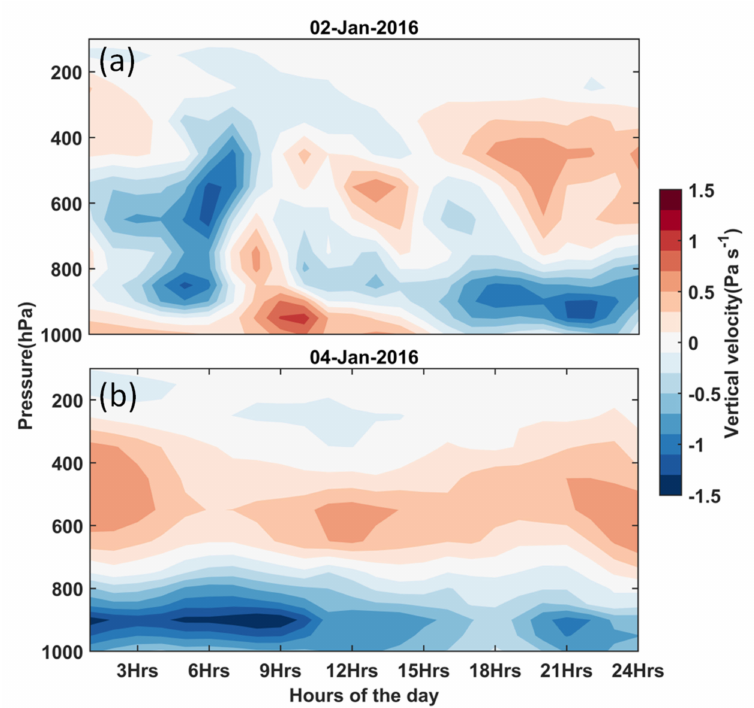
Figure 14. The ERA5 time-height plot for ( a ) heavy rainy day and ( b ) light rainy